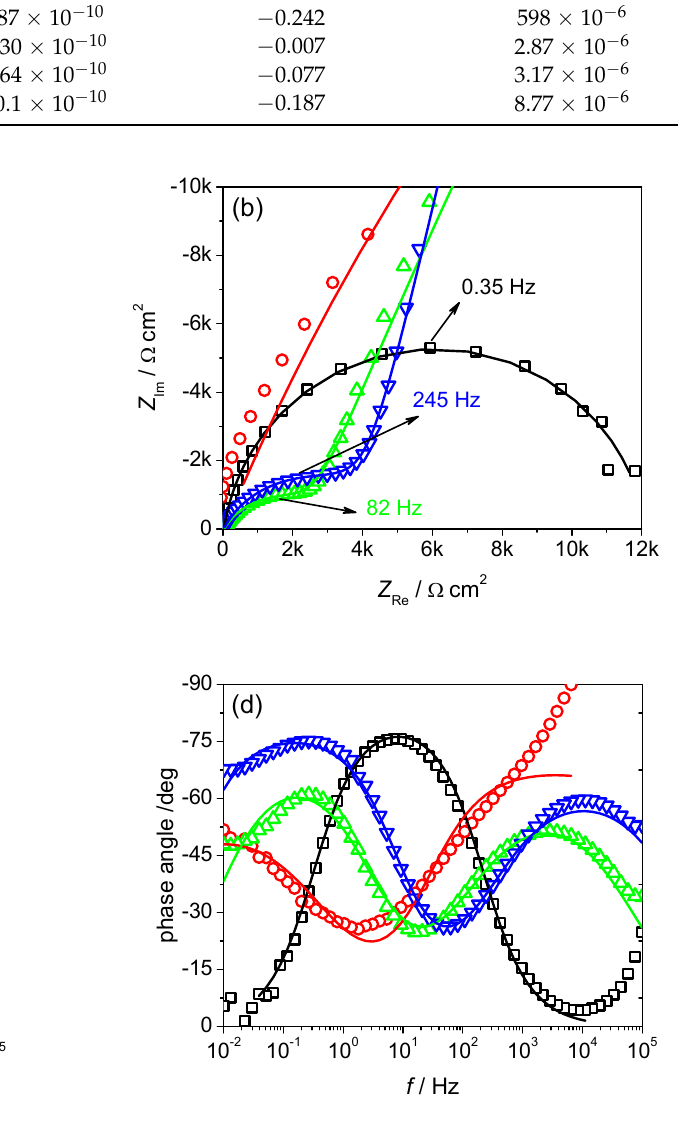
Figure 8. Results of experimental EIS measurements (symbols) in Ringer’s solution at 37 °C for untreated Ti and PEO-treated Ti samples: ( a ) Nyquist plots; ( b ) detail of the high-frequency part of Nyquist plots; ( c ) absolute impedance plots and ( d ) phase angle plots. Continuous lines represent the results of modeling to the EEC given in Figure 8.